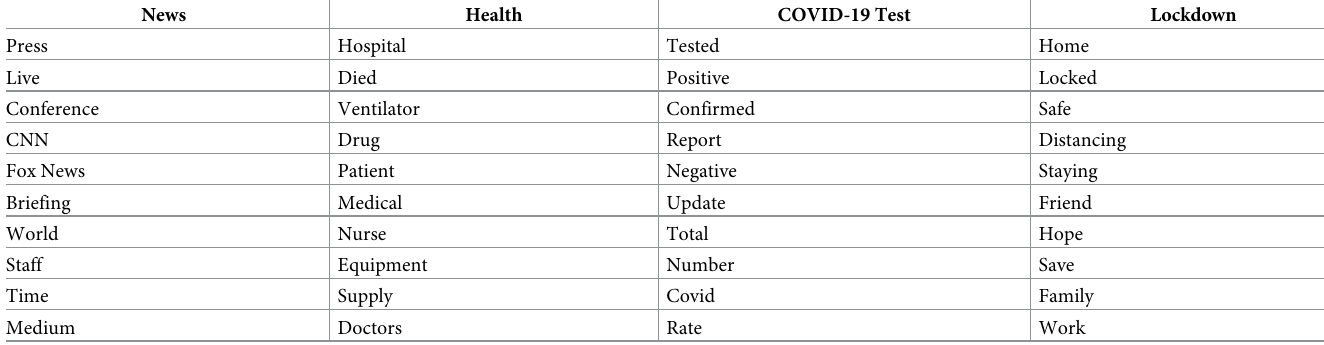
Table 1. Topic word distribution for top- k trending topics in